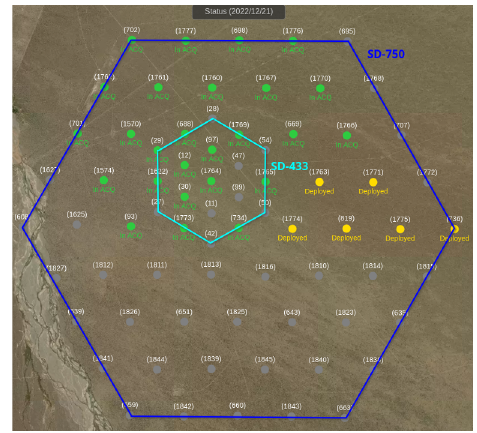
Figure 1. Schematics of the water-Cherenkov surface detec- tors (circles) where UMD positions were deployed (yellow) and are in acquisition (green) in the SD-750 (blue grid) and SD-433 (light blue